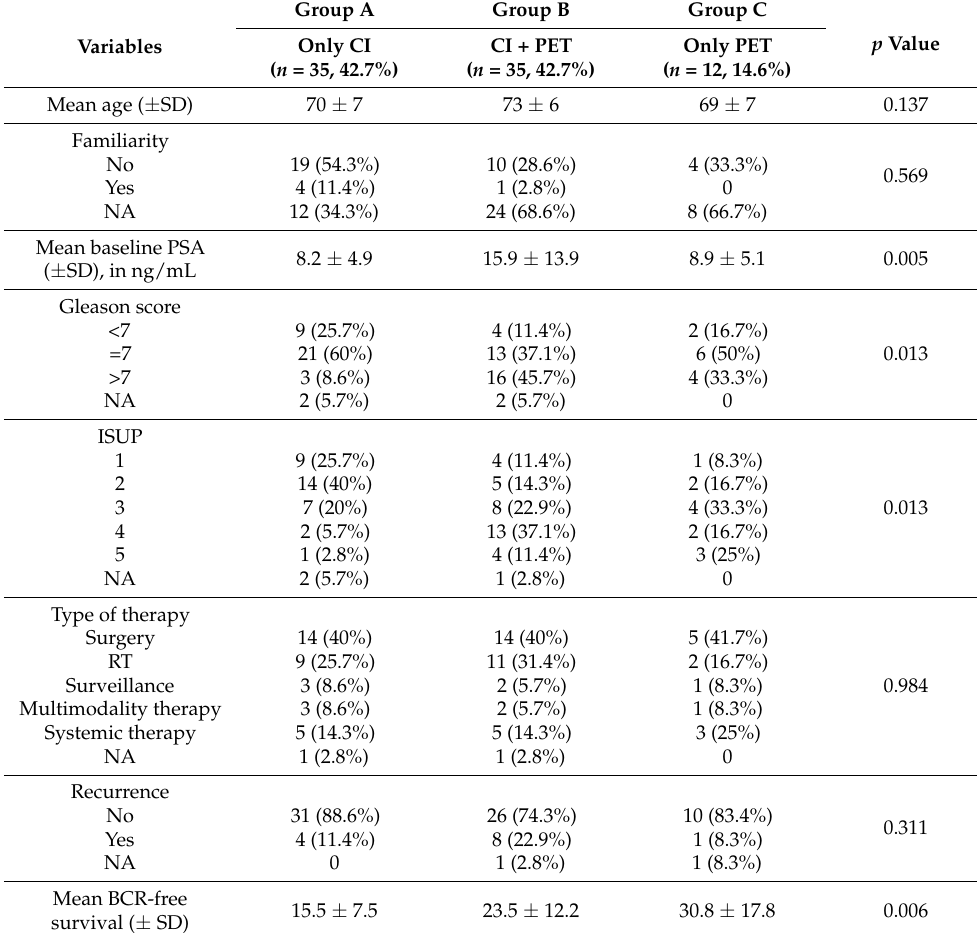
Table 3. Clinical characteristics, imaging findings and outcome for different groups of patients.